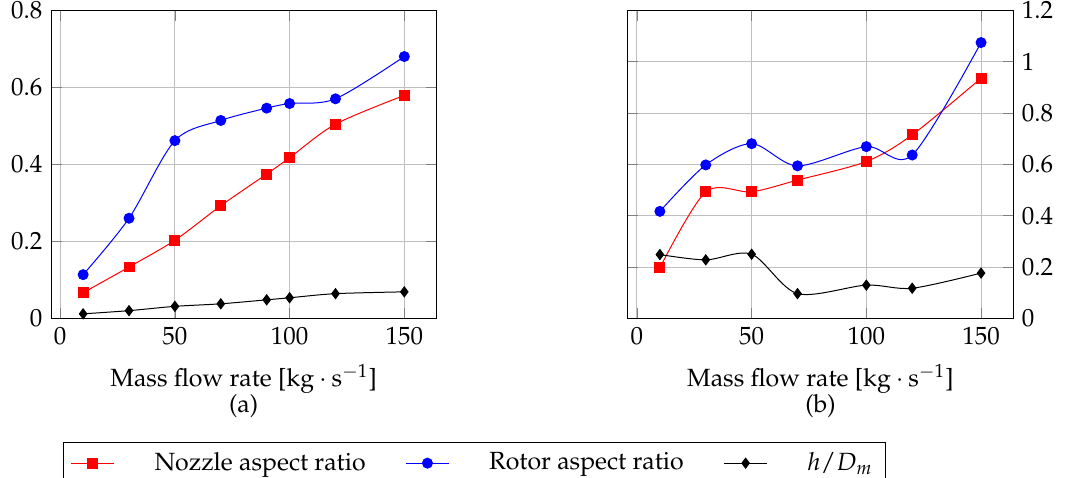
Figure 11. Additional turbine adimensional parameters for the optimal geometric configurations for π = 20 as a function of mass flow rate: ( a ) constant rotational speed and ( b ) optimized rotational speed.